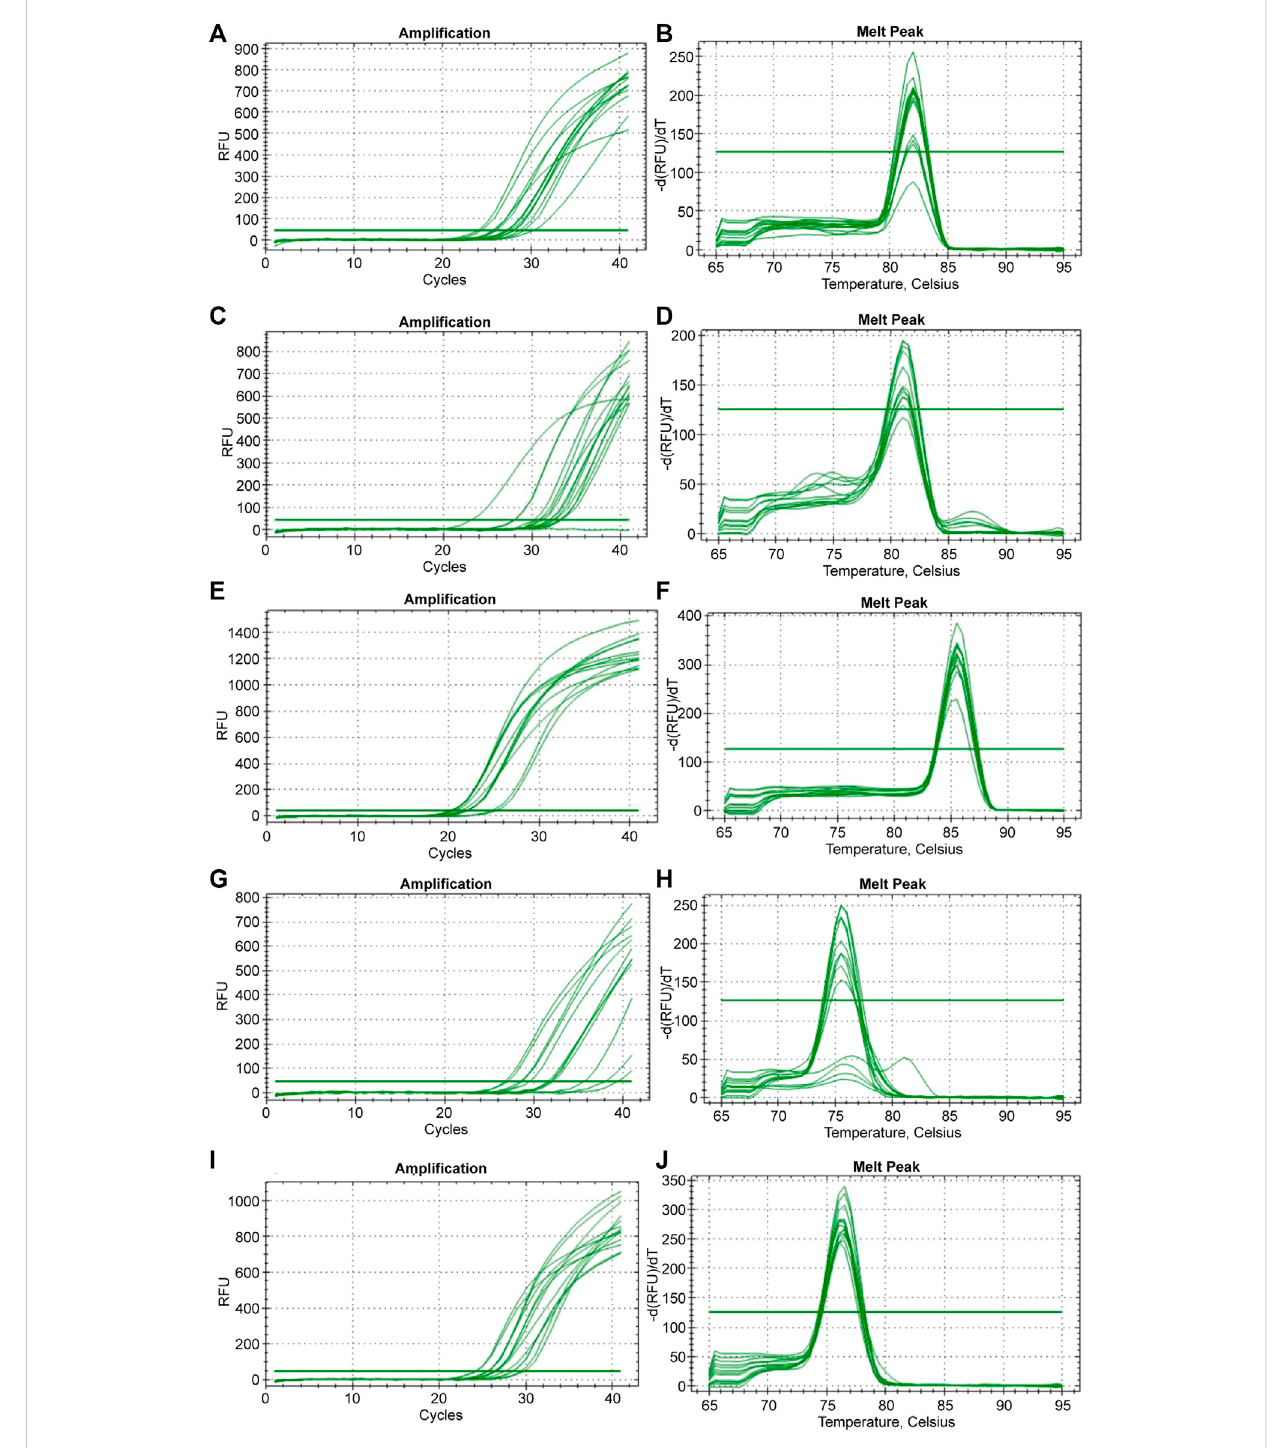
FIGURE 4 The ampli fi cation and dissociation of the ef fi ciency test (melt peak) for the fi vereferencegenes tested in the study: (A, B) B-actin , (C, D) BMP2 , (E, F) GAPDH , (G, H) HPRT1 , and (I, J) RPL5